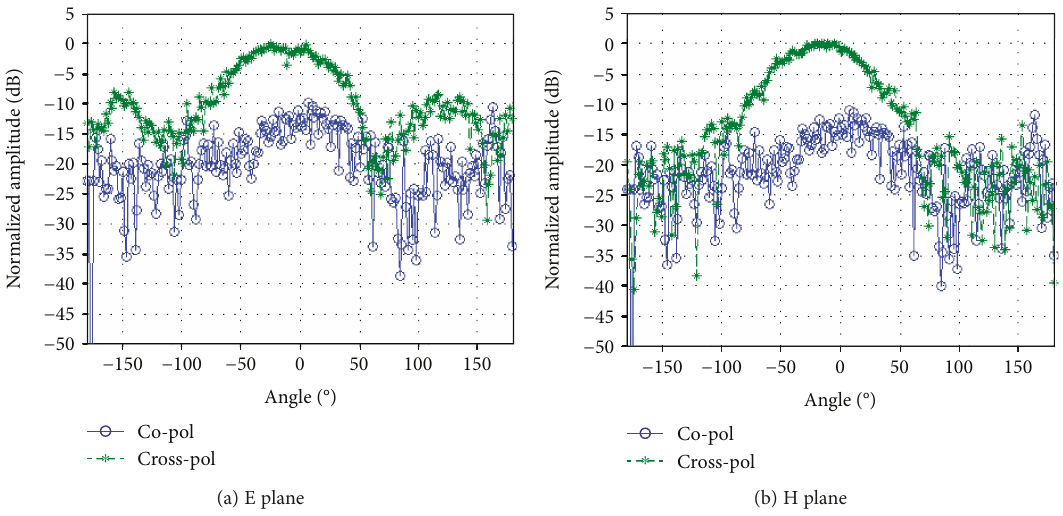
Figure 11: Test patterns of printing dipole